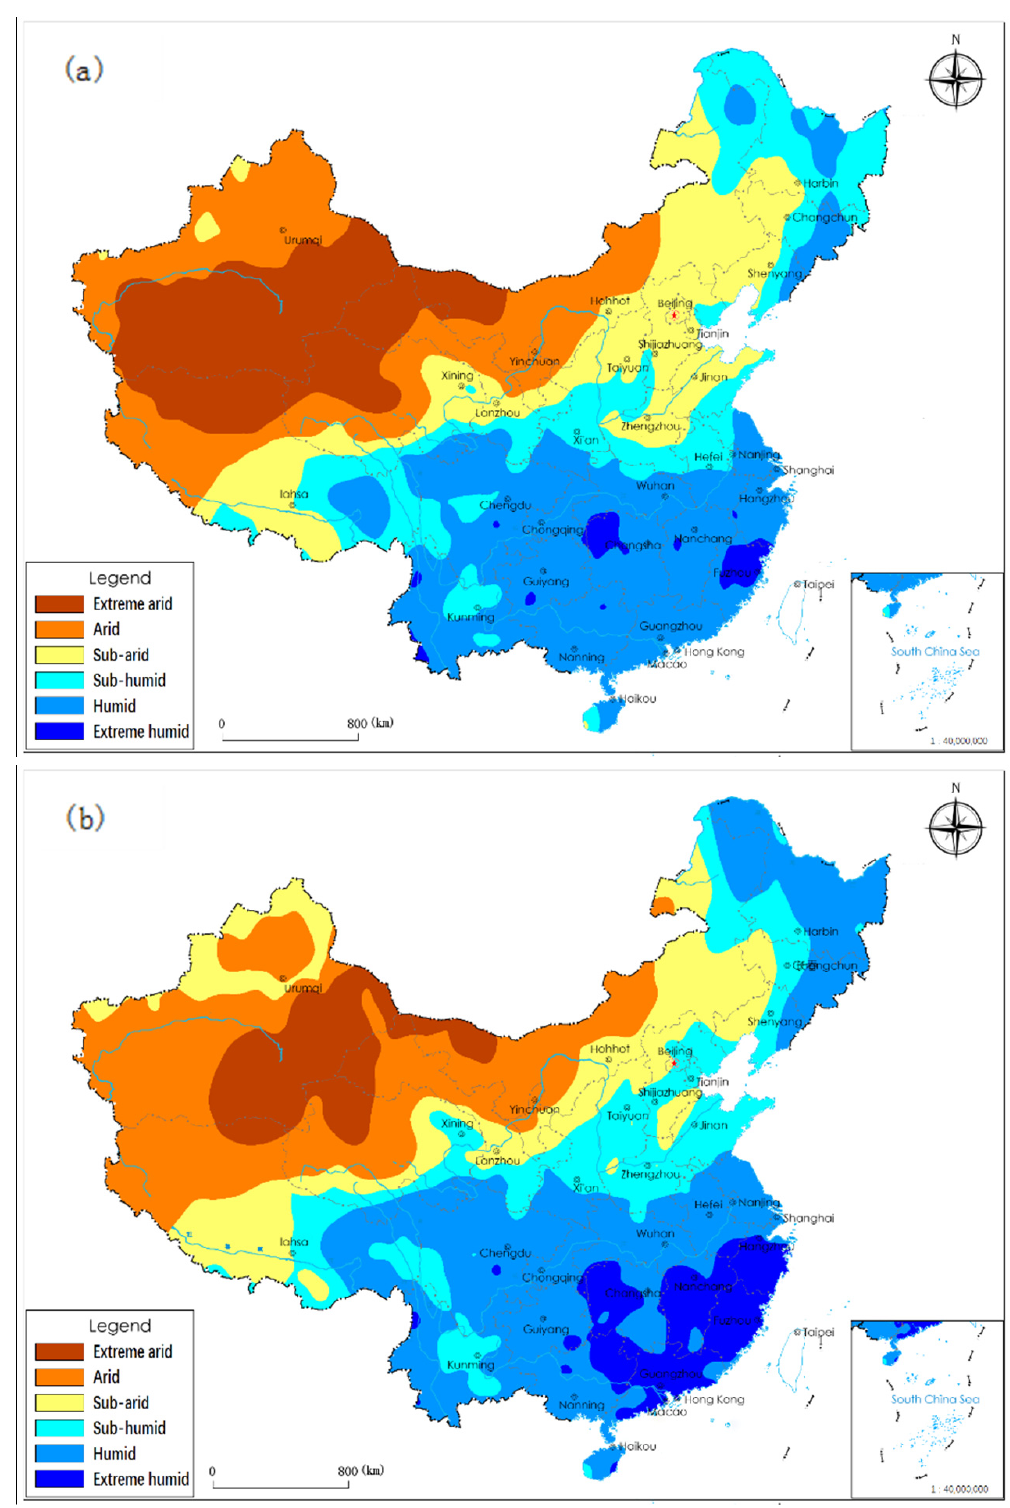
Figure 5. Dry and wet climate zones during 10 years from 1961 to 1970 ( a ); and from 2011 to 2020 ( b ) in China.